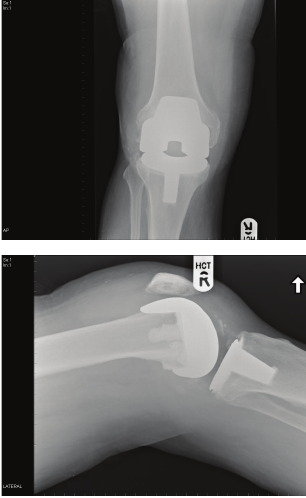
Figure 1: Initial operative AP and lateral radiographs of the right knee.